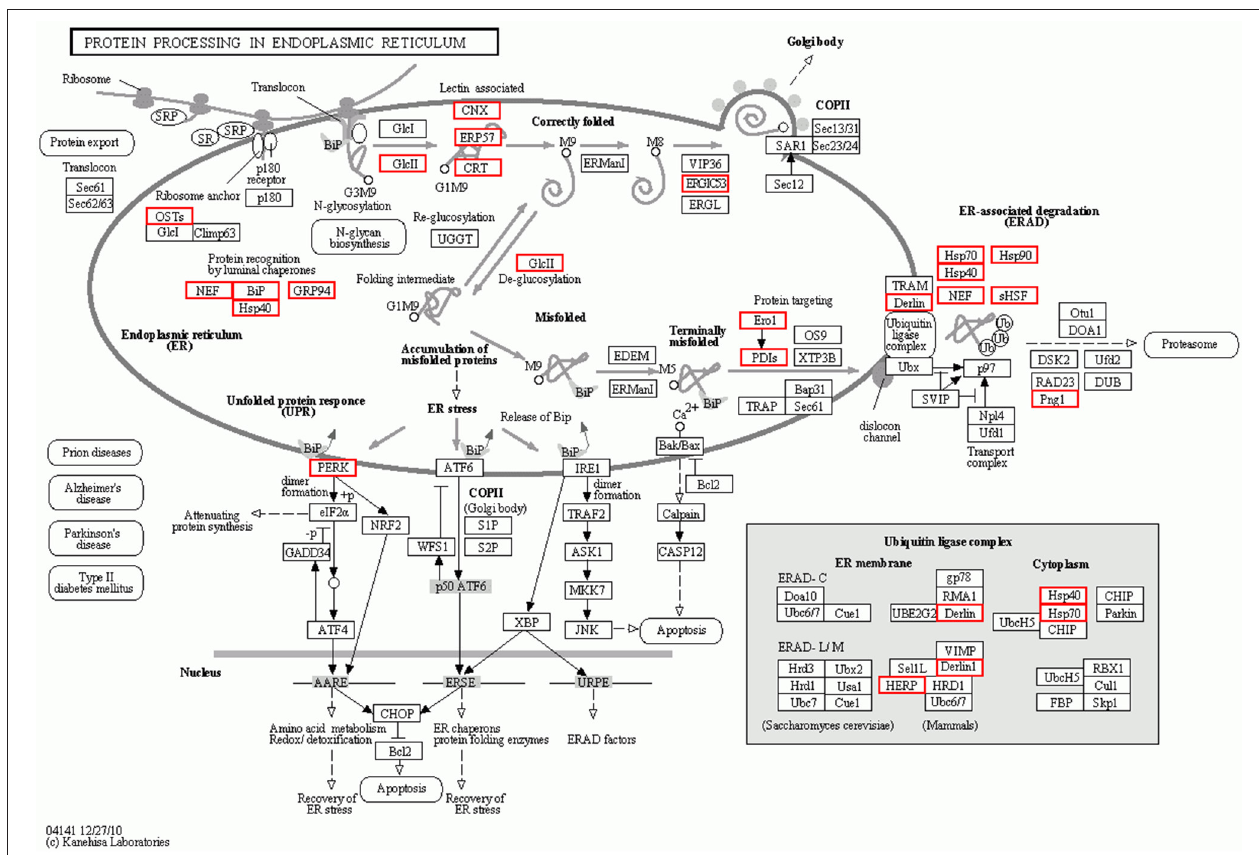
FIGURE 4 | Interaction network of differentially expressed genes involved in protein processing in the endoplasmic reticulum during thermal stress. Genes up-regulated during thermal stress are marked with the red